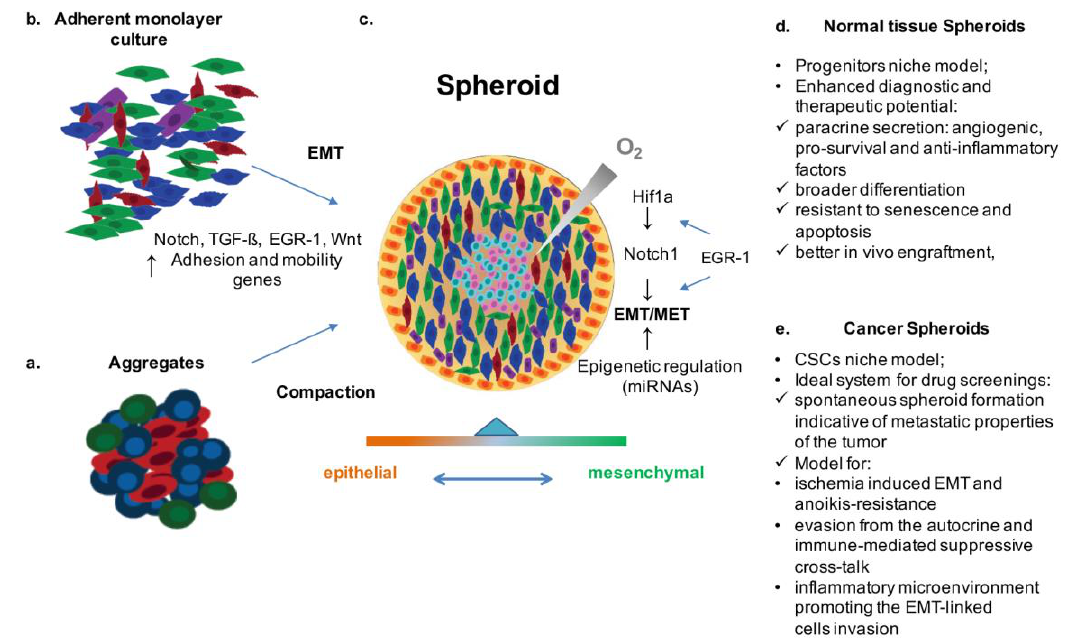
Figure 1. EMT-induced spheroids as an in vitro model of stem cell niches and tumors. Spheroids can be obtained by aggregation and compaction ( a ) or spontaneous formation from monolayer cultures, mediated by activation of EMT related pathway and gene associated with adhesion and motility ( b ). Spheroids are globular and compact structures that can be handled without causing mechanical dissociation of the cells, characterized by a hypoxic core with quiescent cells surrounded by a rim of proliferating cells. The hypoxic gradient activates Notch and other EMT associated pathways favoring the maintenance of a “metastable” state of differentiation within the spheroid ( c ). Characteristics of normal tissue spheroids ( d ) and cancer spheroids ( e ). EMT: epithelial-to-mesenchymal transition; MET: mesenchymal-to-epithelial transition; TGF- β : Transforming Growth Factor-beta; EGR-1: Early growth response protein 1.